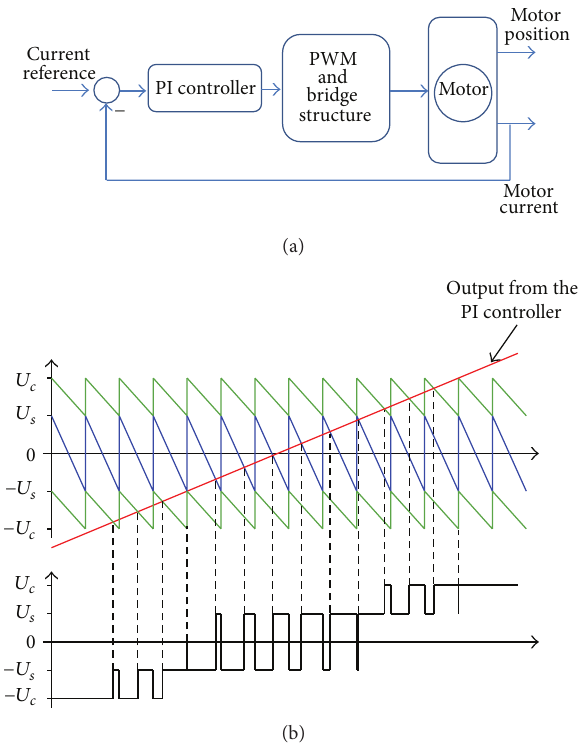
Figure 12: (a) Control scheme using PI controller in the loop. (b) PWM